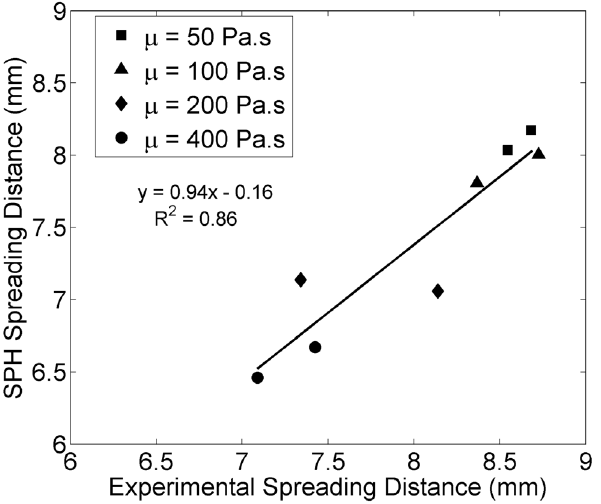
Figure 9. Normalized outlet cement pressure compared between experiments and